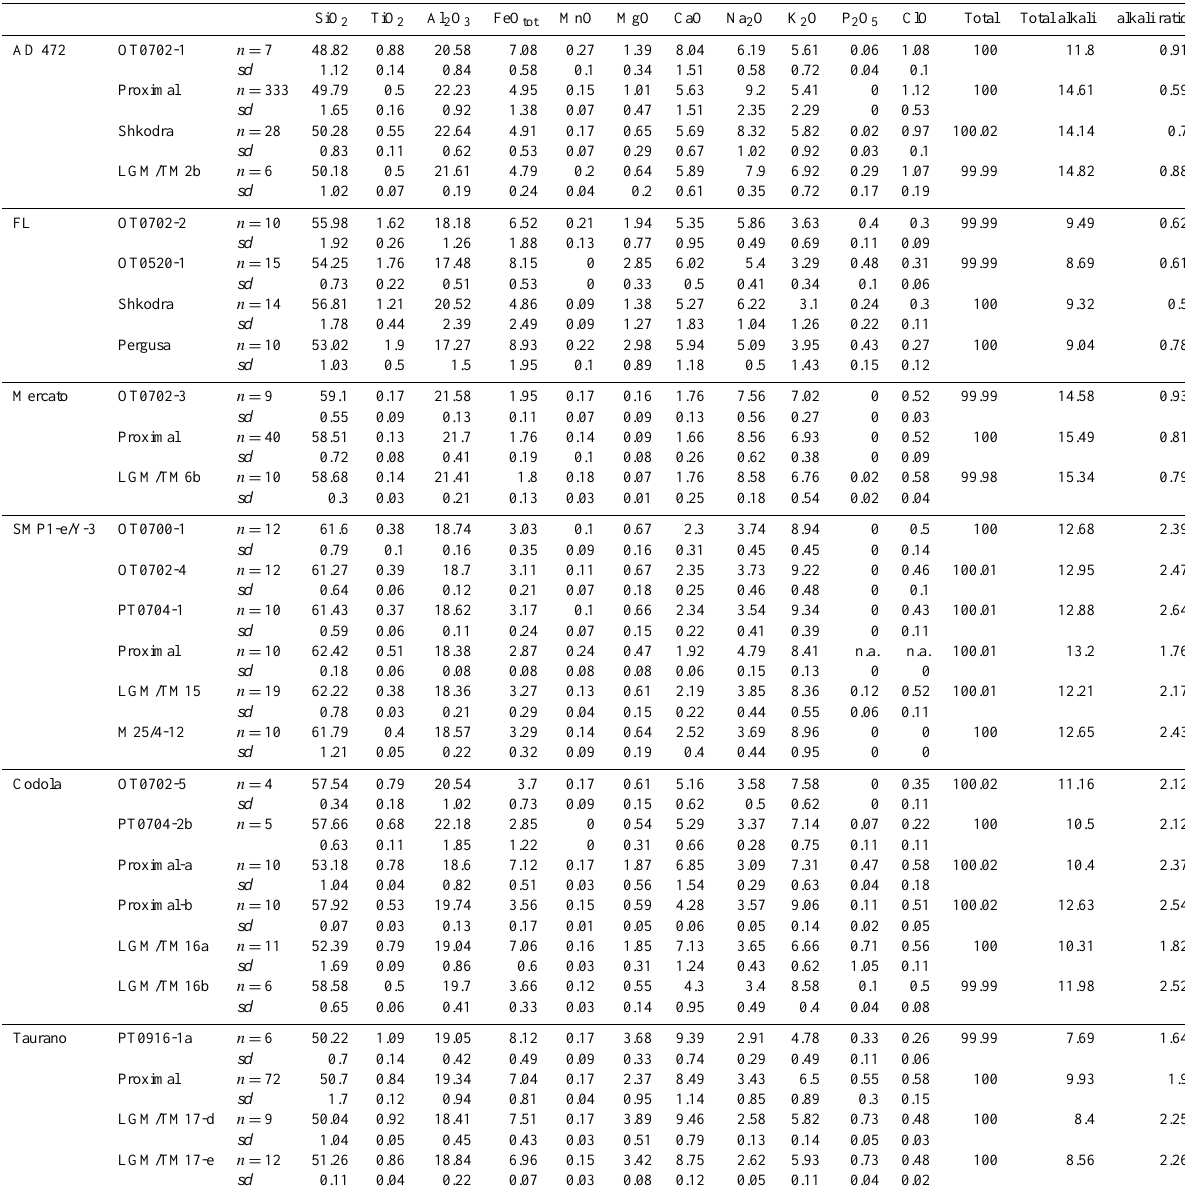
Table 4. Selected analyses (mainly EDS; WDS, EPMA and only for one case XRF) for tephra layers correlated with those found in core Co1202. Data from Lago Grande di Monticchio are from Wulf et al. (2004). Data from S. Gregorio Magno are from Munno and Petrosino (2007). Data for proximal deposits of Mercato are from Santacroce et al. (2008). For Y-3 data see Zanchetta et al. (2008) and Wagner et al. (2008). For Codola see Di Vito et al. (2008), Giaccio et al. (2008). For CI/Y-5 see Di Vito et al. (2008), Giaccio et al. (2008), and Wagner et al. (2008). For the Y-6 see Margari et al. (2007). For the C-20 see Paterne et al. (1988), for P-11 see Paterne et al. (2008). All the literature analyses were normalised to